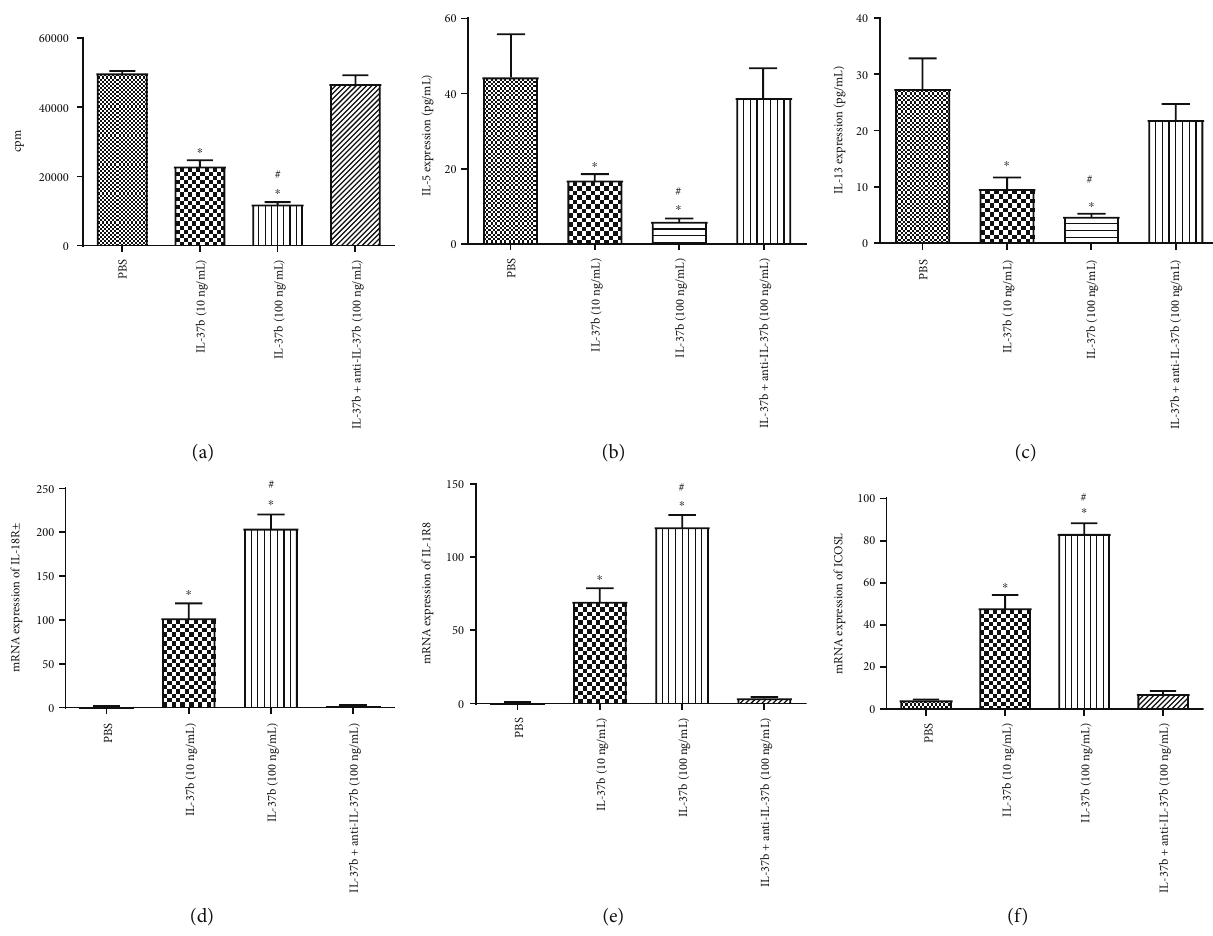
Figure 3: The ILC2 cell proliferation and cytokine expression regulated by IL-37b in AR patients. (a) The proliferation of ILC2 was determined using tritiated thymidine incorporation under IL-37b stimulation. (b, c) The expression of IL-5 and IL-13 by ILC2 under IL-37b stimulation was assessed by ELISA. (d – f) The mRNA expression of IL-1R8, IL-18R α , and ICOSL by ILC2 after stimulated by IL-37b. Three independent tests were performed for every experiment. ∗ ILC2: type 2 innate lymphoid cells; ICOSL: inducible T cell costimulator ligand. Compared with the PBS group, P < 0 : 05 ; # Compared with the IL-37b (10ng/mL) group, P < 0 : 05 .